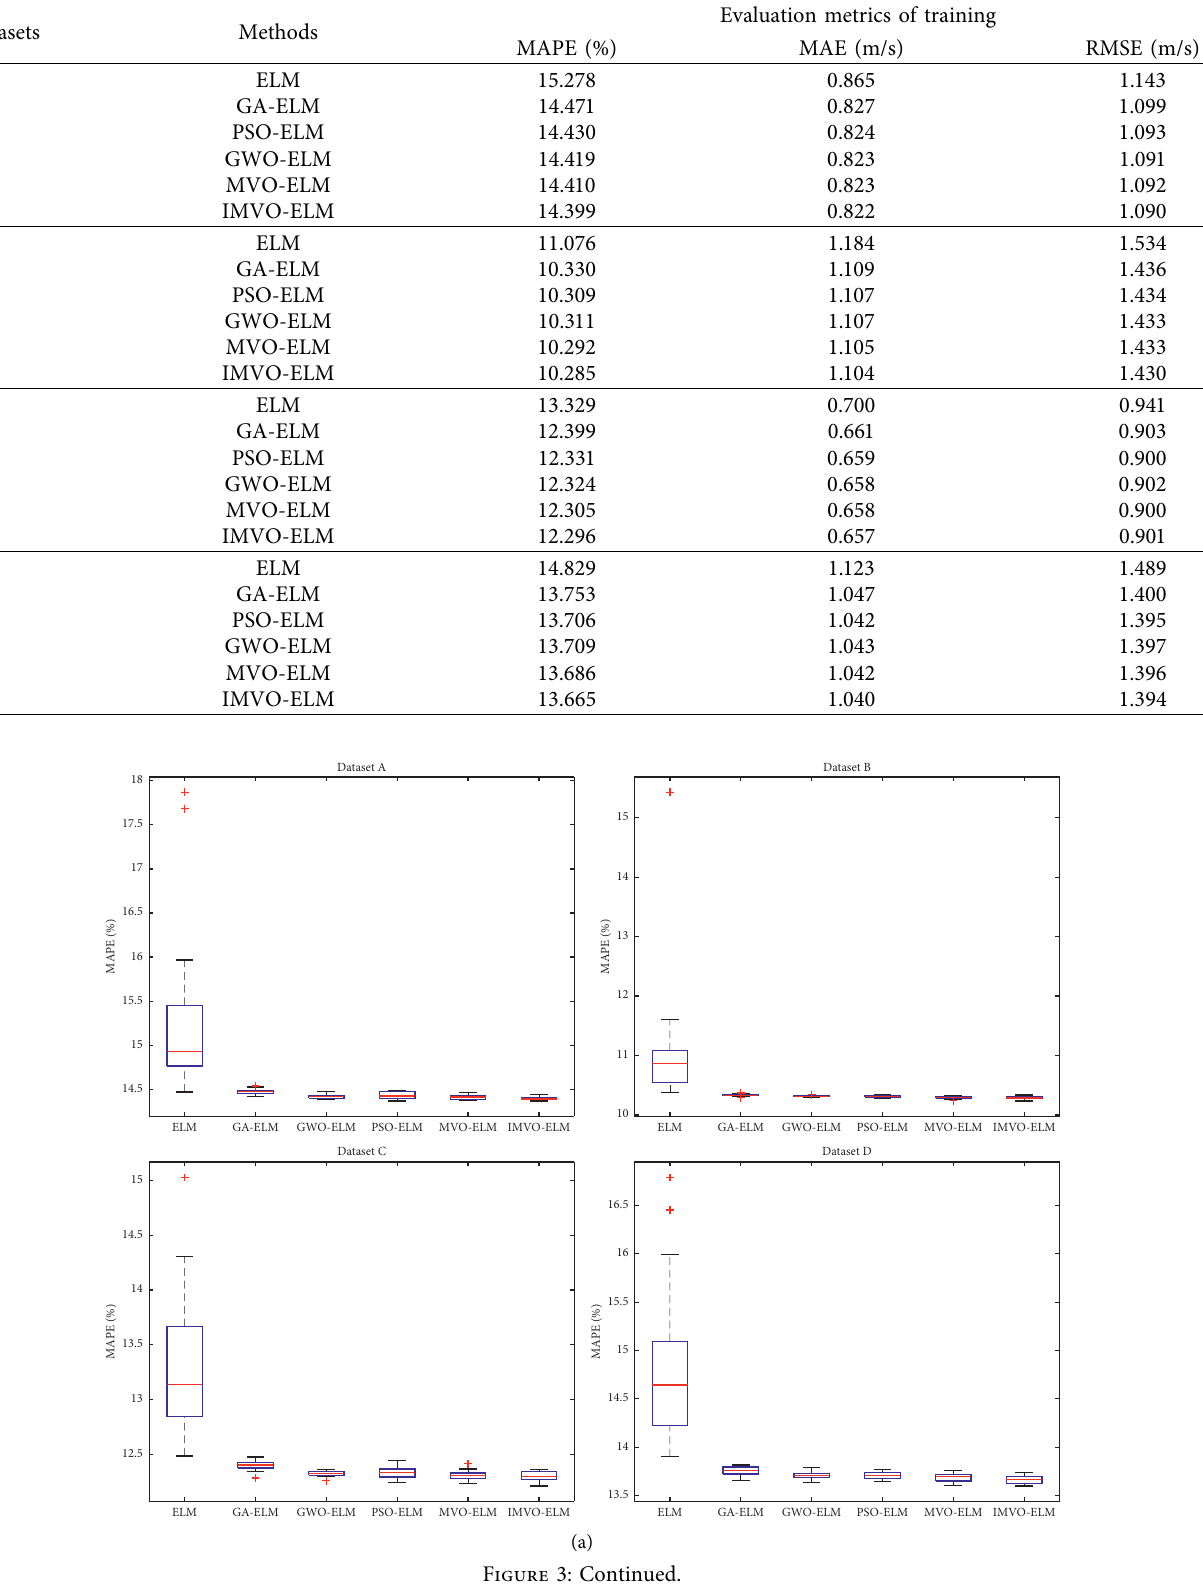
Table 2: The average evaluation metrics of training by different methods with 20 times’ independent